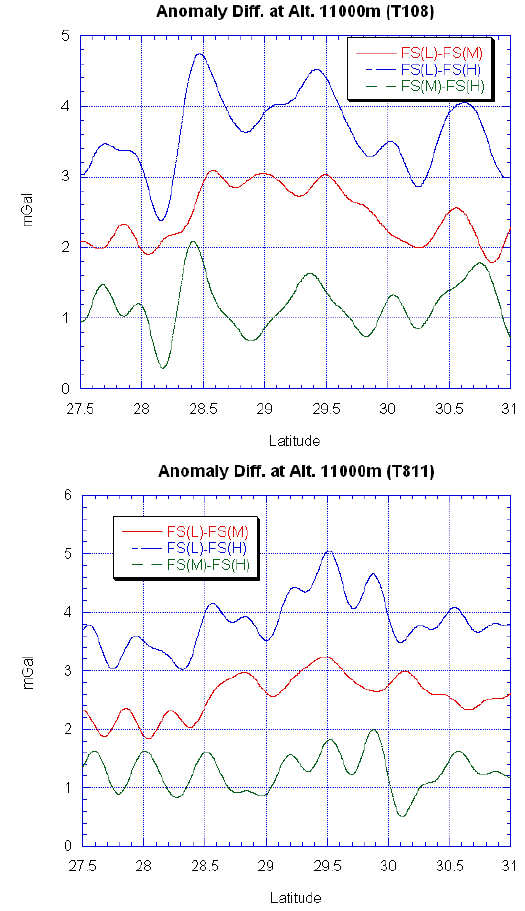
Figure 6. Residual gravity anomalies (centered) on the